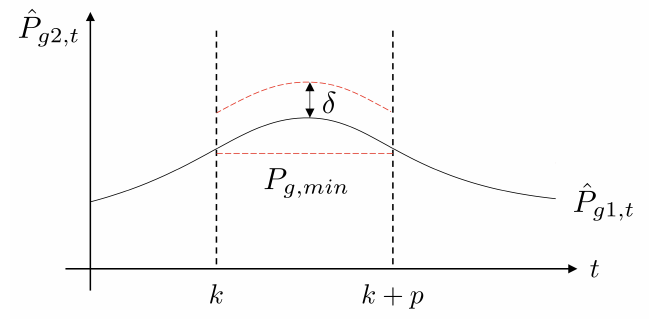
Figure 4. Online ESS optimization.